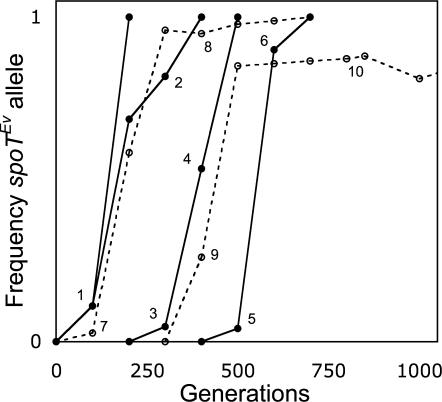
Fixation Dynamics of spoT
Ev Beneficial AllelesSolid lines with filled symbols indicate rec+ lines; dashed lines with hollow symbols indicate rec− lines. The spoT
Ev allele spread significantly faster in rec+ lines. Numbers indicate sample points from which clones with and without a spoT
Ev allele were isolated to allow subsequent fitness measurements (see Figure 3). In one rec− line the spoT
Ev allele had not fixed by 1,000 generations. This line was continued for a further 300 generations, after which time the allele had fixed.